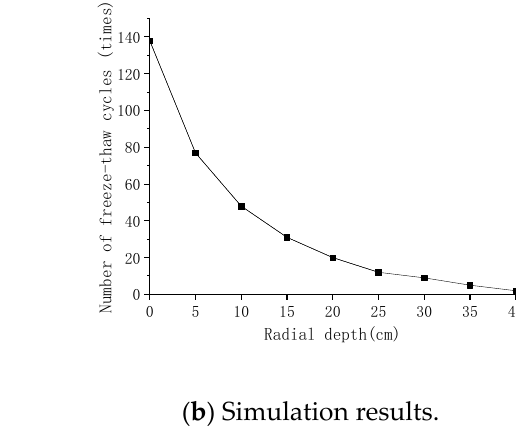
Figure 4. Freeze–thaw cycles of the lining.